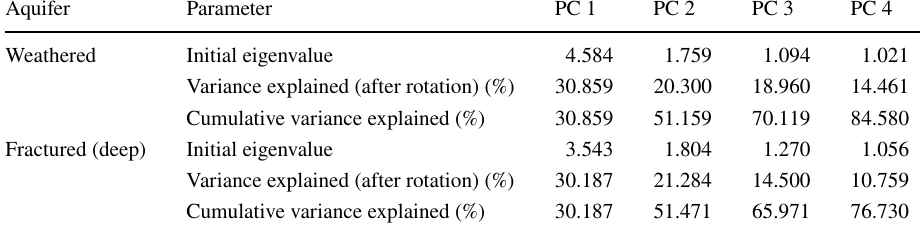
alkaline indices in groundwater from charnockites